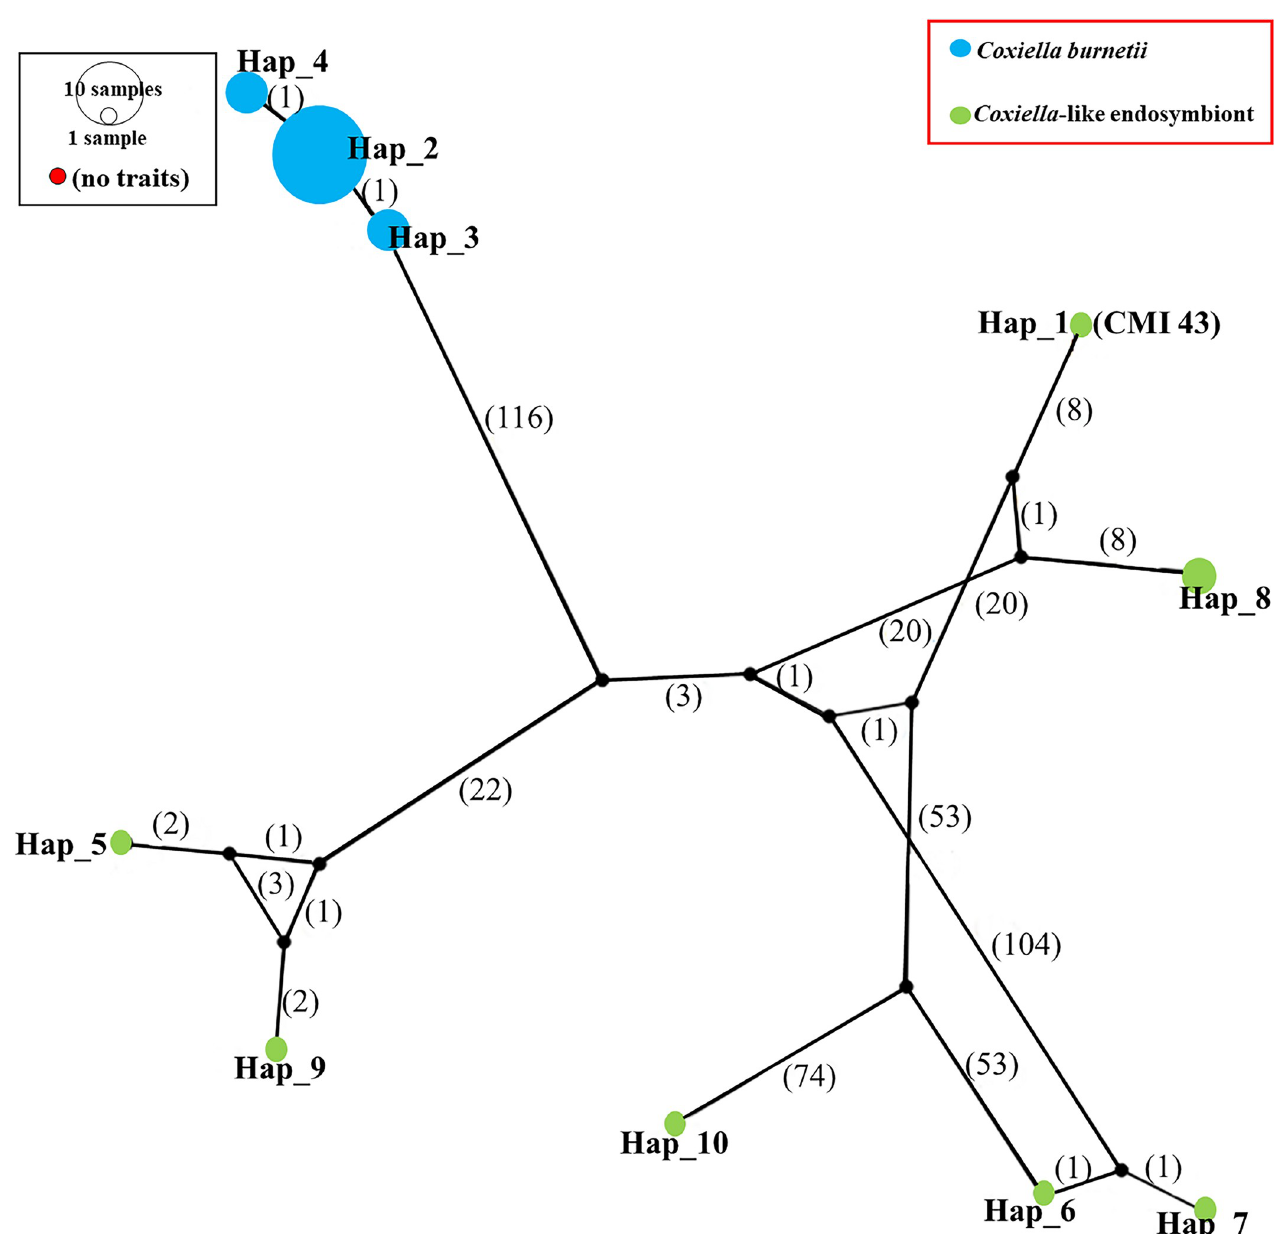
Fig 4. Mutational occurrence network of haplotypes of partial dnaK nucleotide sequences of Coxiella sp. Mutational occurrence network of haplotypes of partial dnaK -encoding genes of CLE and C . burnetii . The number inside each parentheses indicates the value of base substitution among CLEs and C . burnetii . https://doi.org/10.1371/journal.pone.0249354.g004 10–20 fragments of digested peptides were hit to partial DnaK and heat-shock protein 70 of CLE of R . annulatus , Candidatus Coxiella mudrowiae, CLE of Amblyomma americanum , CLE of Hemaphysalis punctate , CLE of Ixodes sp., CLE of Ornithodoros sp., CLE of Amblyomma cajennense , C . burnetii (strain CbuG-Q212), C . burnetii (strain CbuK_Q154), C . burnetii (strain Dugway 5J108-111), C . burnetii (strain RSA 331/Henzerling II) and C . burnetii (strain RSA 493/Nine Mile phase I) (S2 Table).